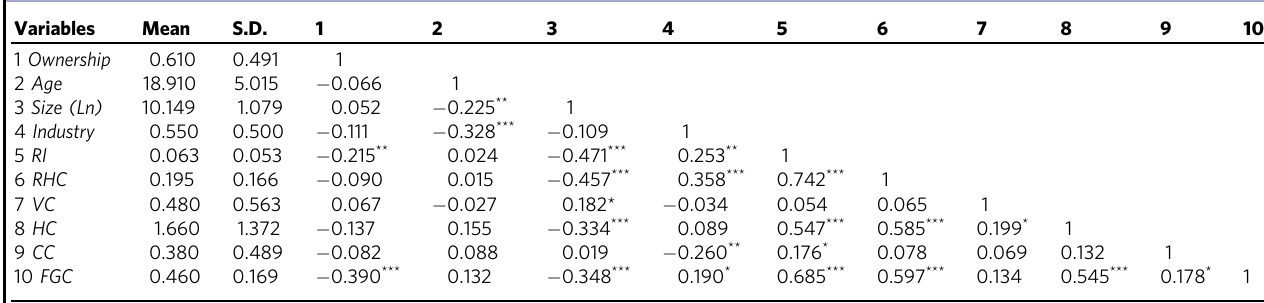
Table 2 Descriptive statistics and correlations.